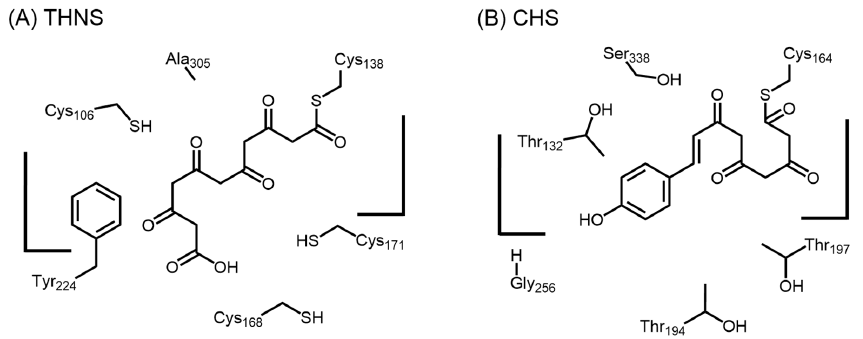
Figure 11. Schematic representation of the active sites of ( A ) S. coelicolor THNS and ( B ) M. sativa